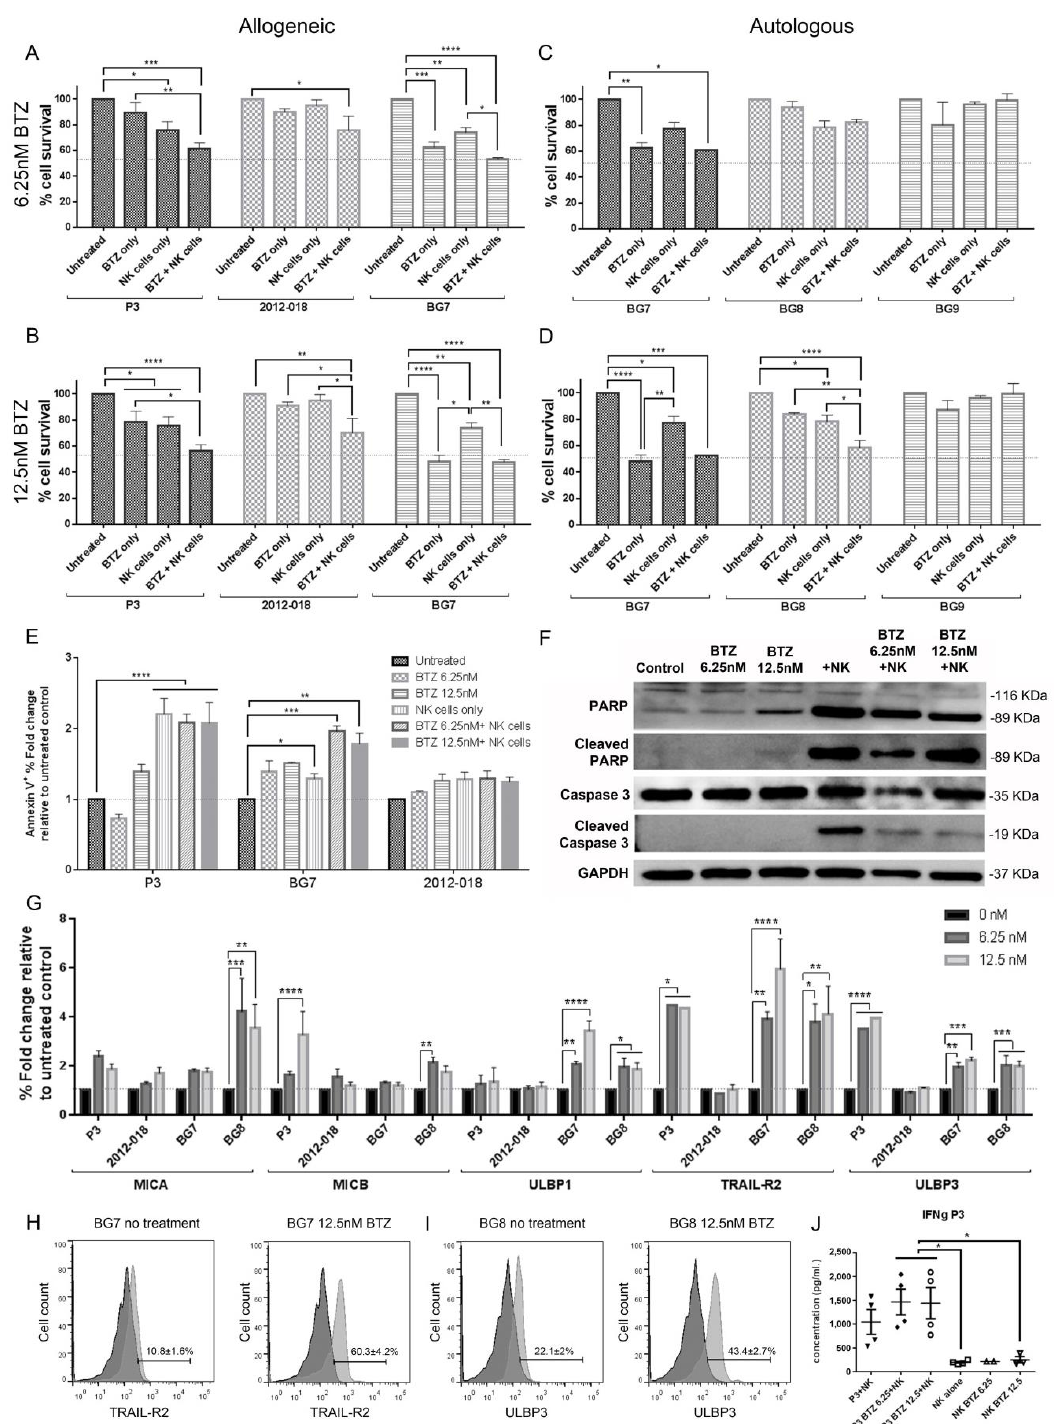
Figure 2. Combination treatment of bortezomib and NK cells against GBM cells. The % fraction of surviving P3, 2012-018 and BG7 cells treated with bortezomib (BTZ), with 5:1 of NK cells or in combination BTZ and 5:1 of NK cells; treated with allogeneic NK cells and ( A ) 6.25 nM or with ( B ) 12.5 nM BTZ, or treated with autologous NK cells and ( C ) 6.25 nM or ( D ) 12.5 nM BTZ. ( E ) The % fold change relative to the untreated control of early apoptotic (Annexin V + ) P3, BG7 and 2012-018 GBM cells after treatment with 6.25 nM BTZ, 12.5 nM BTZ, 5:1 NK cells and combination of 6.25 nM or 12.5 nM BTZ with 5:1 NK cells. ( F ) Western blot analysis of poly (ADP-ribose) polymerase (PARP) and caspase 3 proteins in lysates (20 µg of protein) from P3 cells untreated or treated with 6.25 nM and